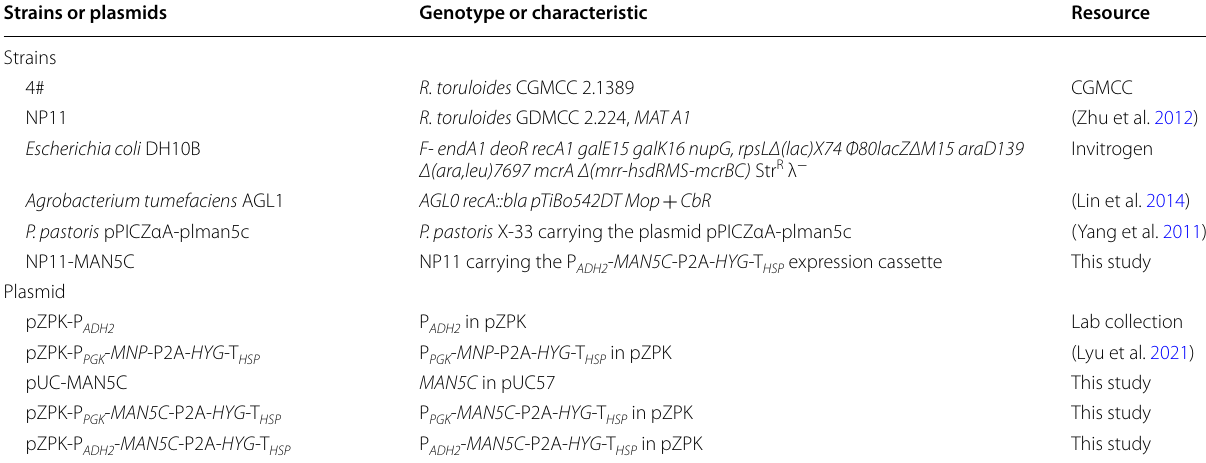
Table 1 Strains and plasmids used in this study Strains or